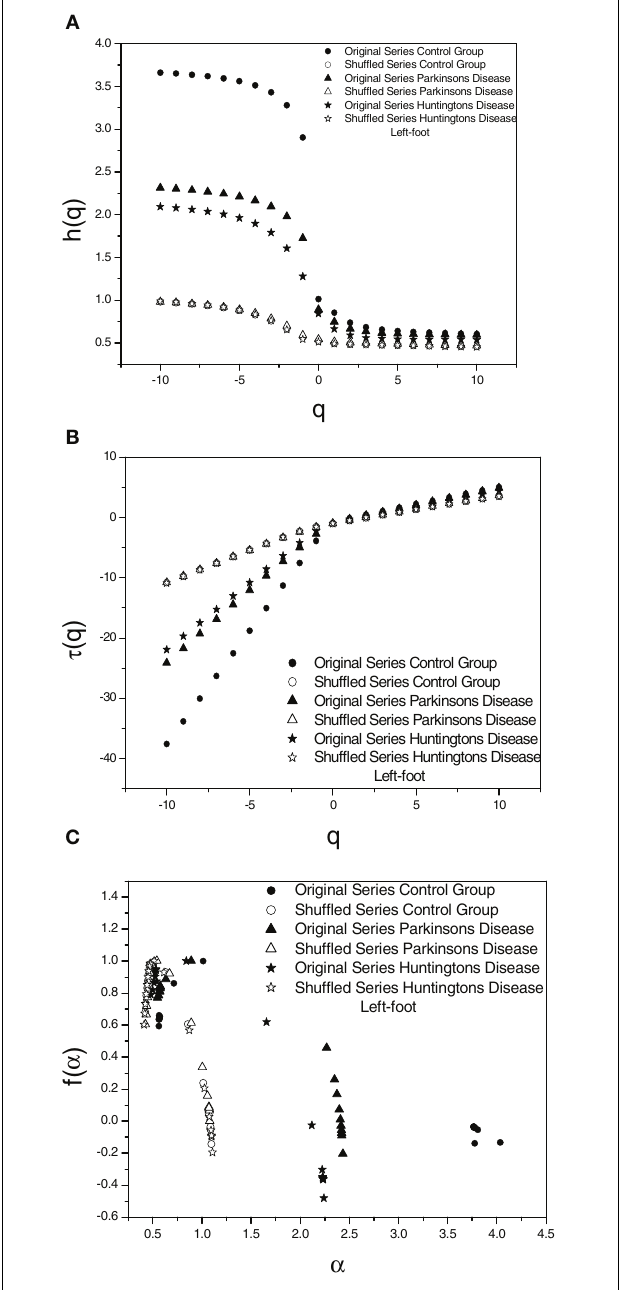
FIGURE 2 | Plot of (A) Generalized Hurst exponent h ( q ) vs. order q (B) Classical Scaling exponent (Equation 5) τ ( q ) vs. order q and (C) Dimension of subset series (Equation 6) f ( α ) vs. Singularity strength (Equation 7) α for original and shuffled series for one set each of three different cases for